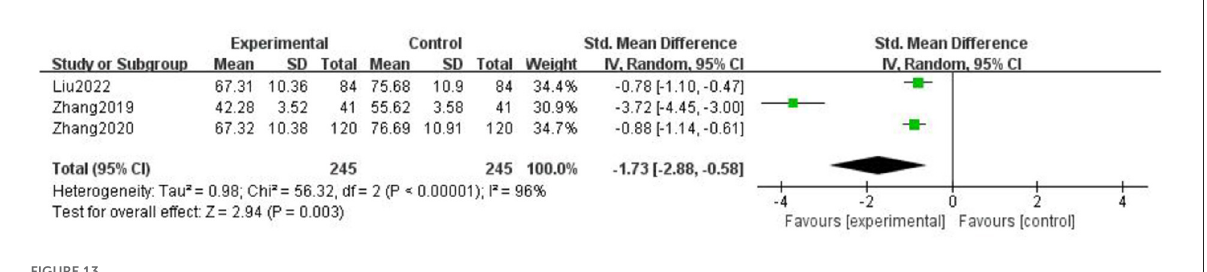
FIGURE13 Forest chart of average blood flow velocity of MCA.